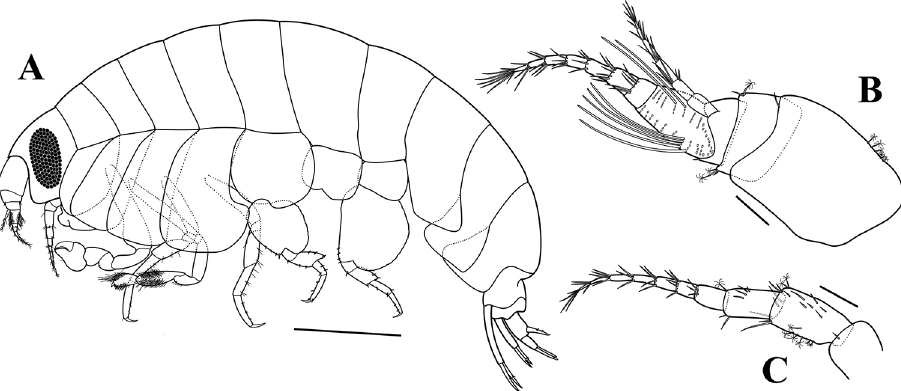
Figure 4. Opisa parvimana sp. nov. paratype, adult female, MARBK-301, 7.2 mm A habitus B antenna 1 C antenna 2. Scale bars: 1.0 mm ( A ), 0.1 mm ( B, C